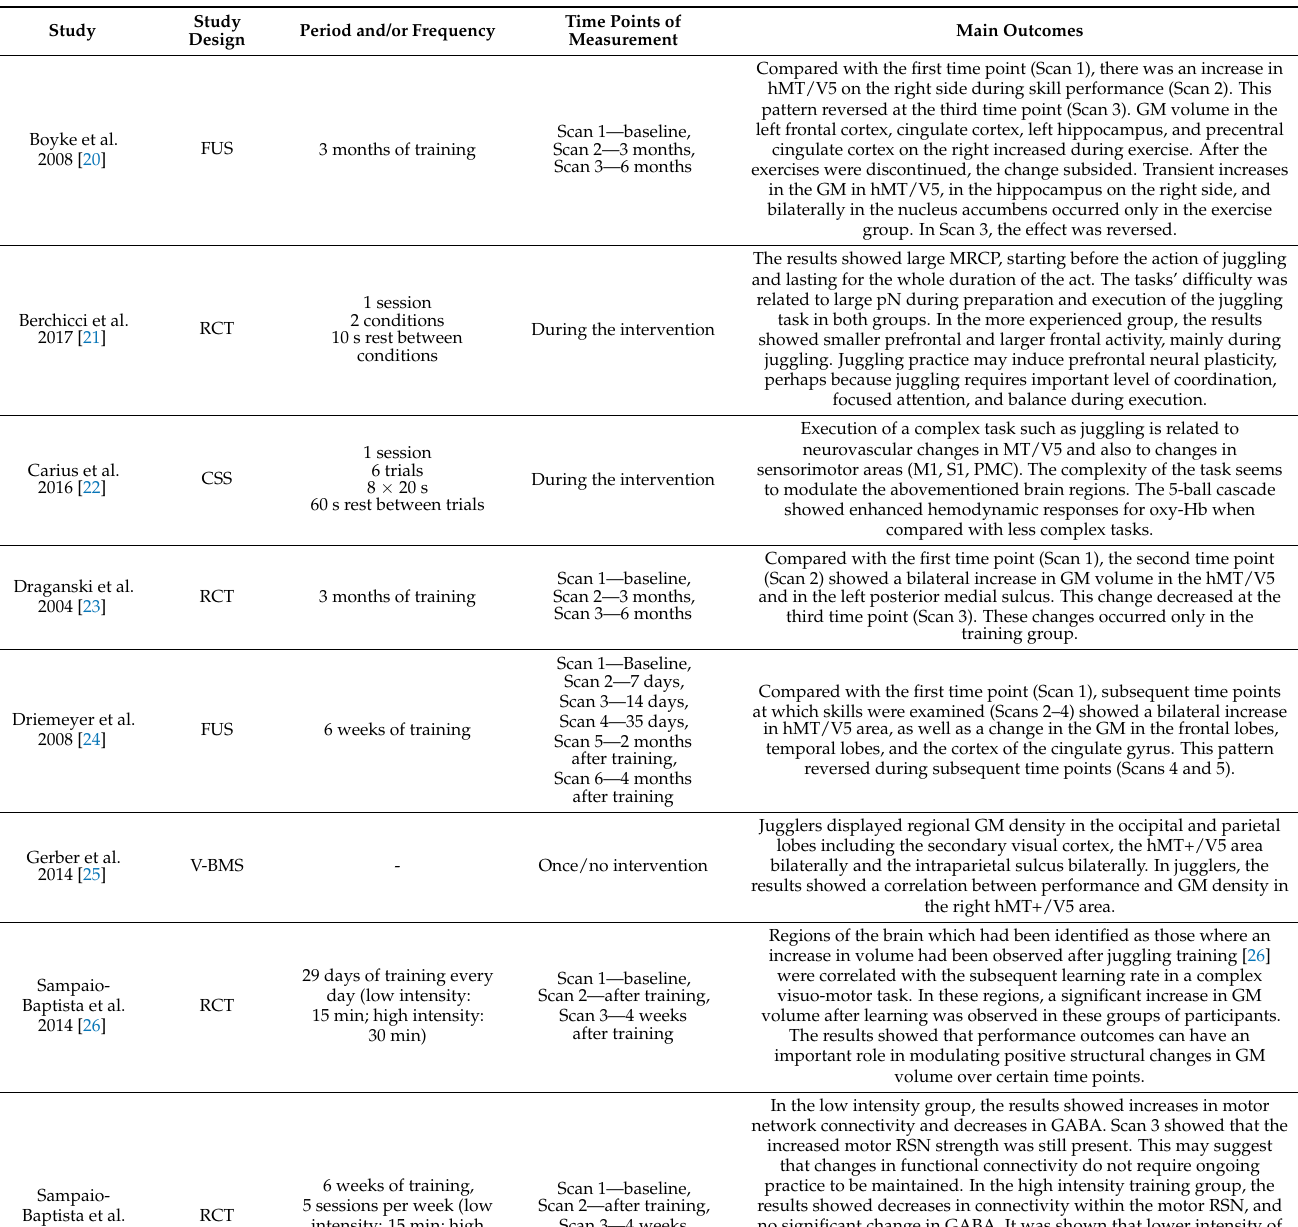
Table 2. Summary of study design, period, time points of measurement and